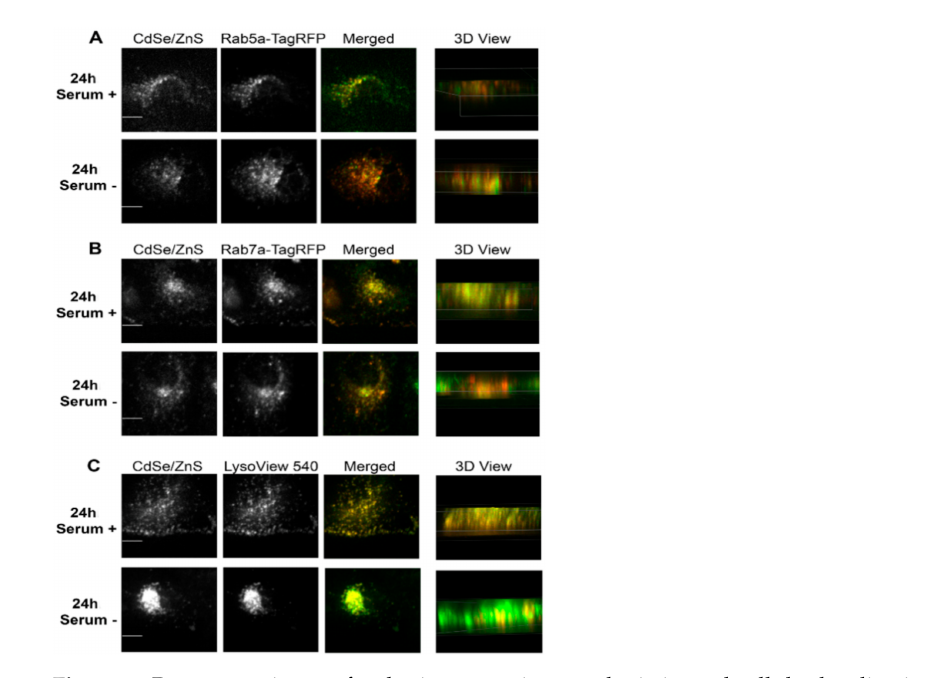
Figure 6. Representative confocal microscope images depicting subcellular localizations of green CdSe/ZnS-COOH QDs after 24 h treatment with QDs in ML-1 cell culture. ( A , top ) Colocalization of the early endosome reference marker Rab5a-TagRFP with the QDs in the presence of serum. ( A , bottom ) Colocalization of QDs with Rab5a-TagRFP in cells grown in the medium lacking serum. ( B , top ) Colocalization of the late endosome reference marker Rab7a-TagRFP with the QDs in the presence of serum. ( B , bottom ) Colocalization of QDs with Rab7a-TagRFP in cells grown in the medium lacking serum. ( C , top ) Colocalization of the lysosome reference marker LysoView 540 with the QDs in the presence of serum. ( C , bottom ) Colocalization of QDs with LysoView 540 in cells grown in the medium lacking serum. Scale bars correspond to 10 µ m.